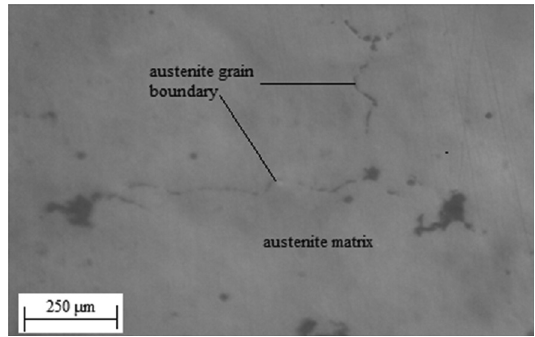
Figure 14. Optical micrograph of heat treated sample in agitated water bath. The microstructure shows austenite grain boundaries in austenite